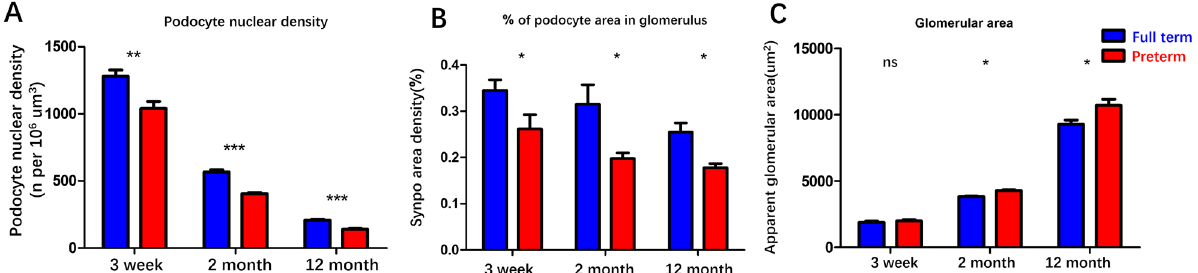
Figure 5. Podometric biopsy parameters in full-term and preterm rats at three time points. ( A , B ) Podocyte nuclear density and podocyte nuclear number per glomerulus in preterm rats were significantly decreased compared with those in full-term rats. In addition, podocyte nuclear density in preterm rats gradually decreased over time. Podocyte nuclear density in the preterm rats was decreased from 18.7 to 32.4% (mean value when compared with that of full-term rats). ( C ) The glomerular area was greater in the preterm rats compared to the term rats at 2 and 12 months. (*** P < 0.001; ** P < 0.01, * P < 0.05; ns: no statistically significant